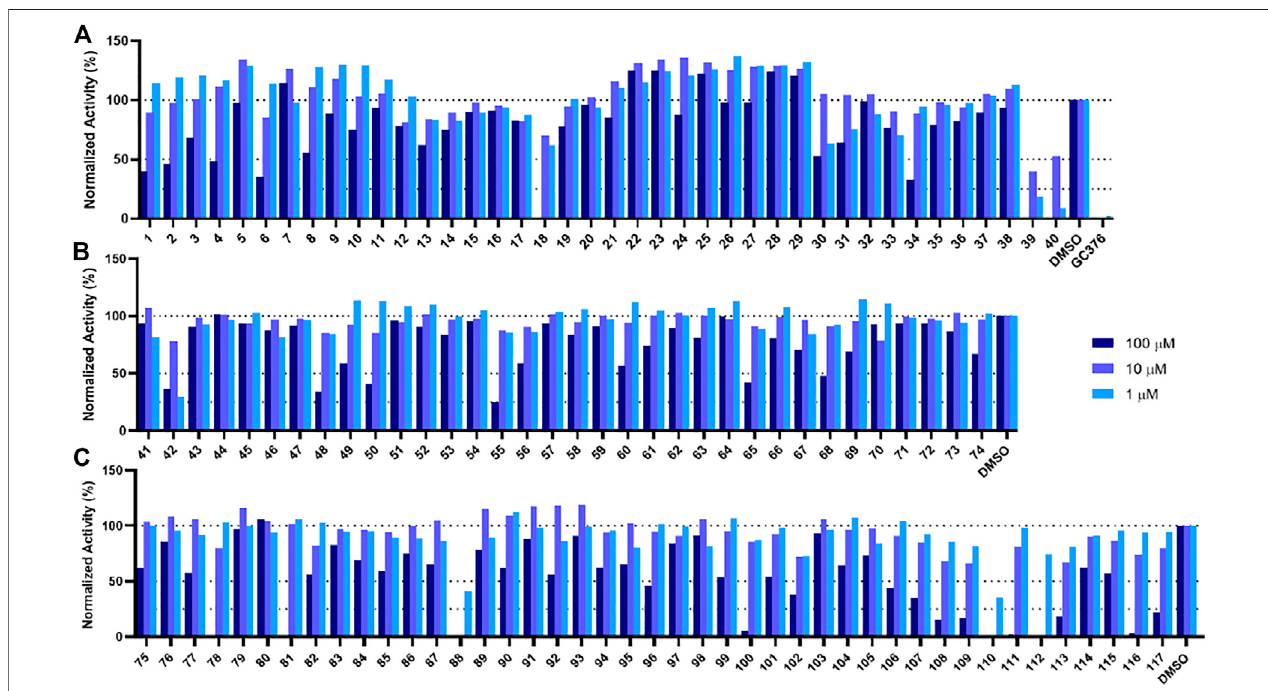
FIGURE4| InitialscreeningofMproinhibitionbyselectedcompoundsfromdocking.Testedcompoundsareselectedfrom (A) thebatchselectedwithaf fi nityfrom receptor-rigid docking, (B) the batch selected with binding energy vs . molecular weight from receptor-rigid docking, and (C) the batch selected from receptor- fl exible docking. 100, 10 and 1 µM were used for each inhibitor to perform the inhibition assay. Fluorescence intensity was monitored with respect to the control that had no inhibitor provided.